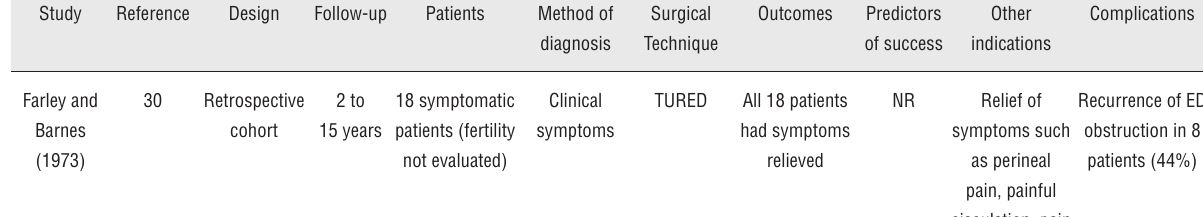
Table 2 - Characteristics of studies reporting treatment outcomes for patients with ejaculatory duct obstruction. Study